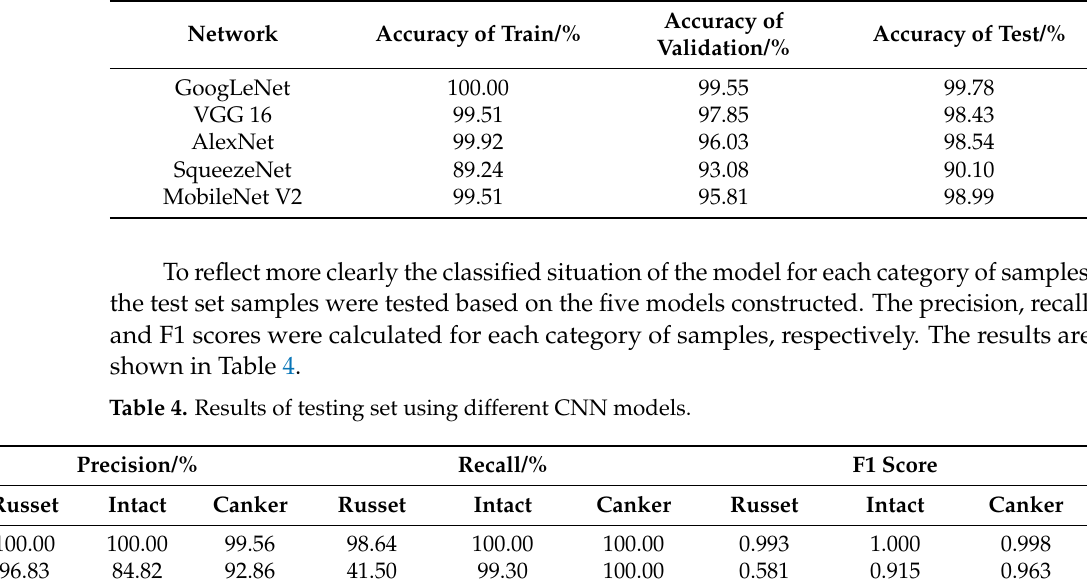
Table 3. Results of training and validation using different CNN models.